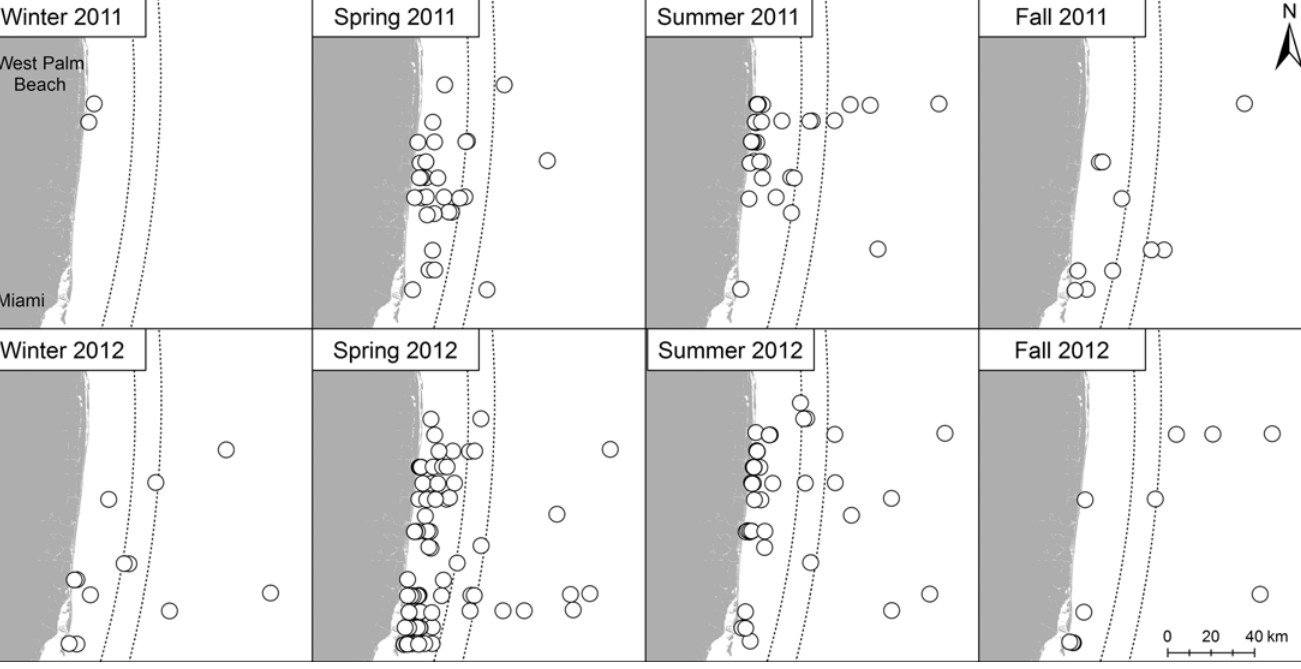
Fig 2. Seasonal sightings of sea turtles from aerial surveys conducted in 2011 – 2012. Each symbol represents a single sea turtle. Dotted lines represent the approximate location of the core of the Florida Current. Source: Florida Fish and Wildlife Conservation Commission-Fish and Wildlife Research